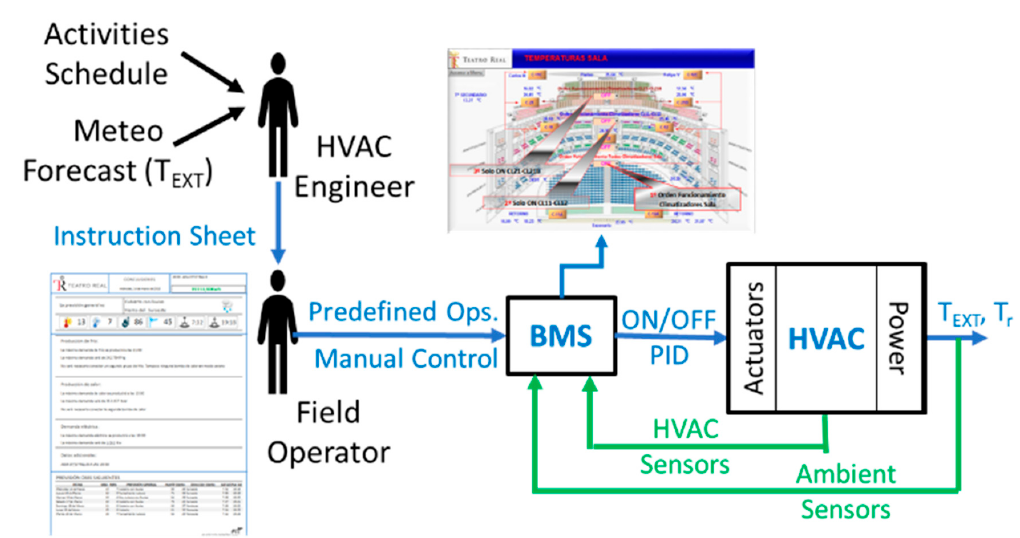
Figure 3. Standard HVAC system operations in Teatro Real of Madrid.